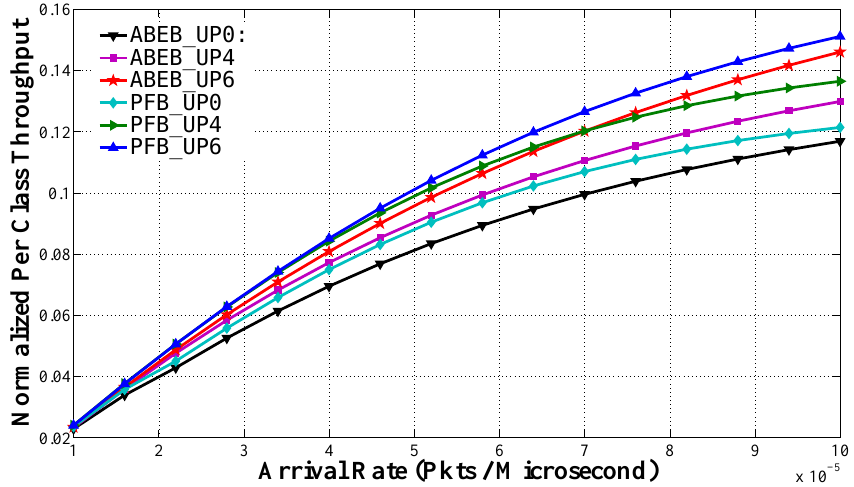
Figure 13. Normalized per class throughput in the heterogeneous case for different backoff